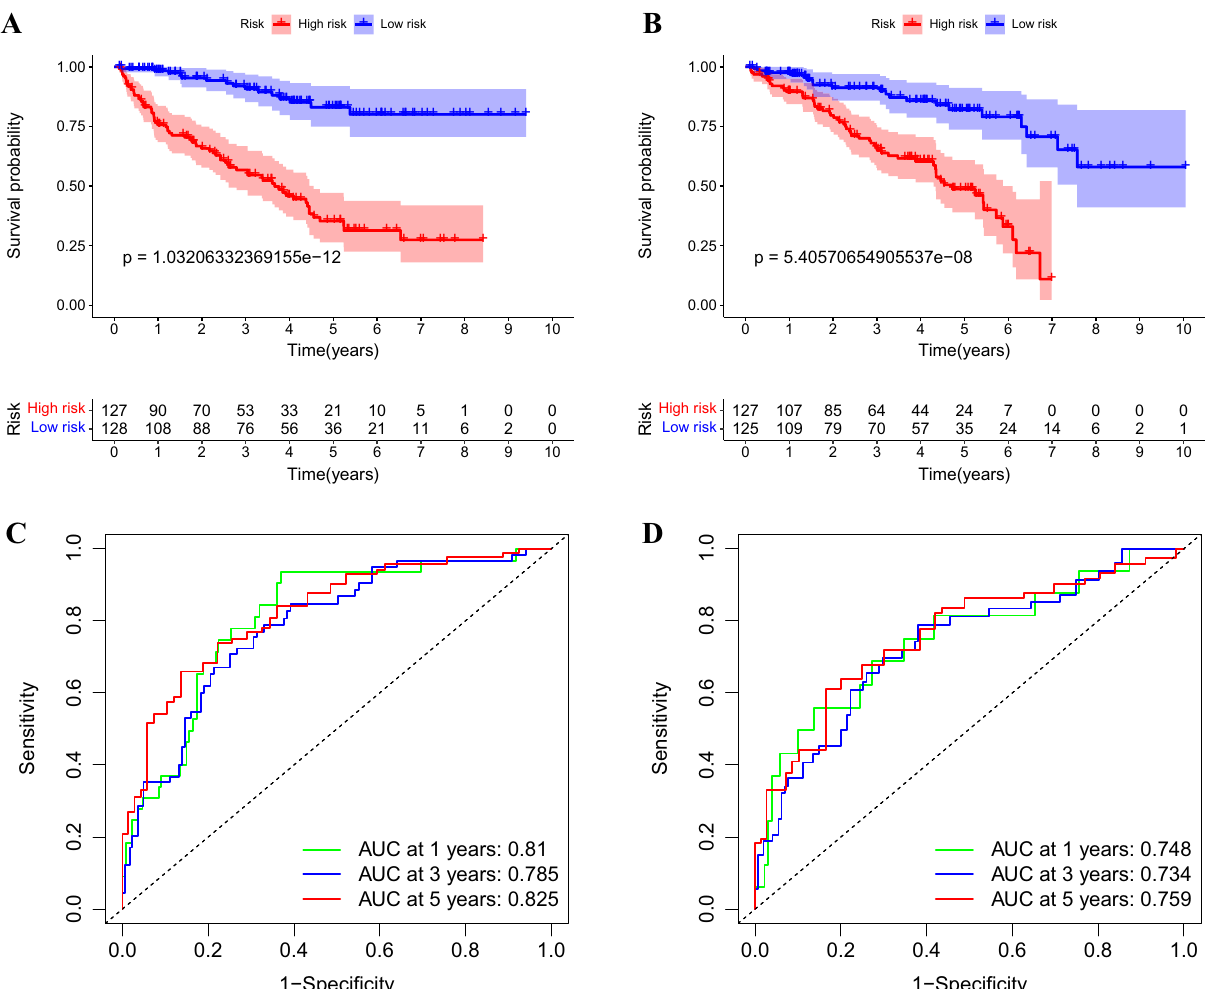
Figure 6. Internal validation of overall survival prediction signature based on the entire TCGA dataset. ( A ) Kaplan–Meier survival curves for the training cohort. ( B ) Kaplan–Meier survival curves for the testing cohort. ( C ) ROC curves and AUC values for 1-, 3-, and 5-years survival for the training cohort. ( D ) ROC curves and AUC values for 1-, 3-, and 5-years survival for the testing cohort. TCGA, the Cancer Genome Atlas; ROC, receiver operating characteristic; AUC, area under the